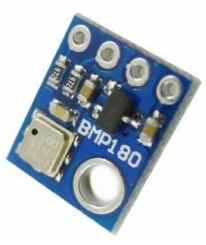
Figure 4. The BMP180 digital pressure sensor. Table 3. Key features of the BMP180.